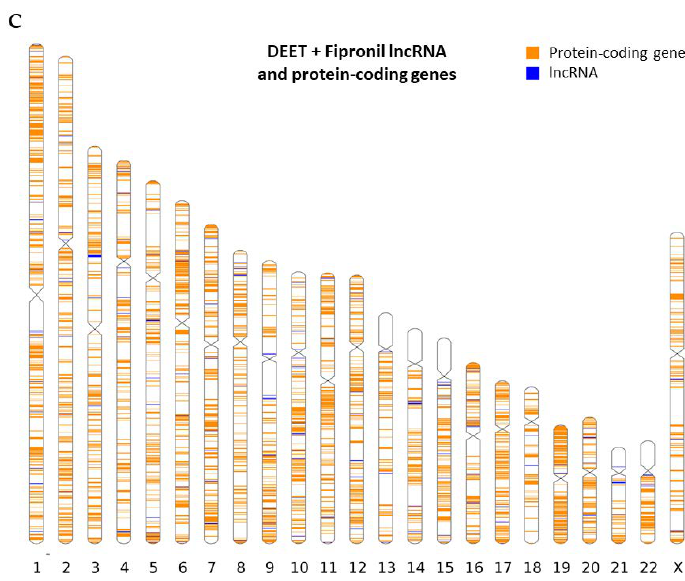
Figure 3. Chromosome maps showing location of lncRNAs with differentially expressed transcripts in relation to dysregulated protein-coding genes after exposure of primary human hepatocytes to 100 µM DEET, 10 µM fipronil, or a mixture of 100 µM DEET and 10 µM fipronil. ( A ) Chromosomal location of lncRNAs and protein-coding genes significantly dysregulated ( p ≤ 0.01) when hepatocytes exposed to 100 µM DEET; ( B ) chromosomal location of lncRNAs and protein-coding genes significantly dysregulated ( p ≤ 0.01) when hepatocyt es exposed to 10 µM fipronil; ( C ) chromosomal location of lncRNAs and protein-coding genes significantly dysregulated ( p ≤ 0.01) when hepatocytes exposed to a mixture of 100 µM DEET and 10 µM fipronil. For ( A ), blue bars and gene symbols denote identity and location of lncRNAs with differentially expressed transcripts (both up- and downregulated). Orange bars and gene symbols denote identity and location of lncRNAs with differentially expressed protein-coding gene transcripts (both up- and downregulated). For ( B and C ), blue bars denote location of lncRNAs with differentially expressed transcripts (both up- and downregulated). Orange bars denote location of protein-coding genes with differentially expressed transcripts (both up- and downregulated).